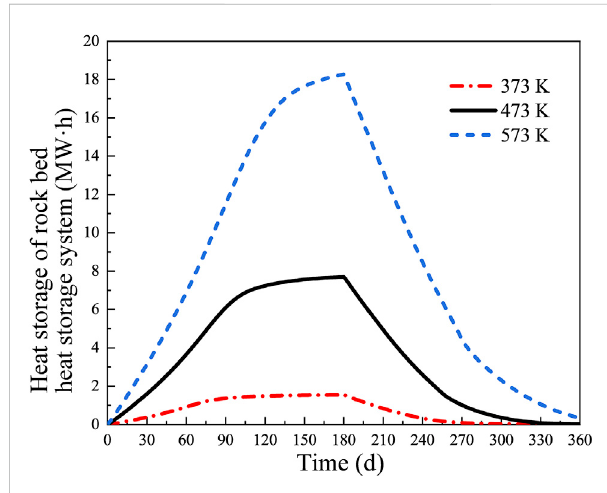
FIGURE 11 The change of rock bed heat storage with time under different CO2 injection temperatures.